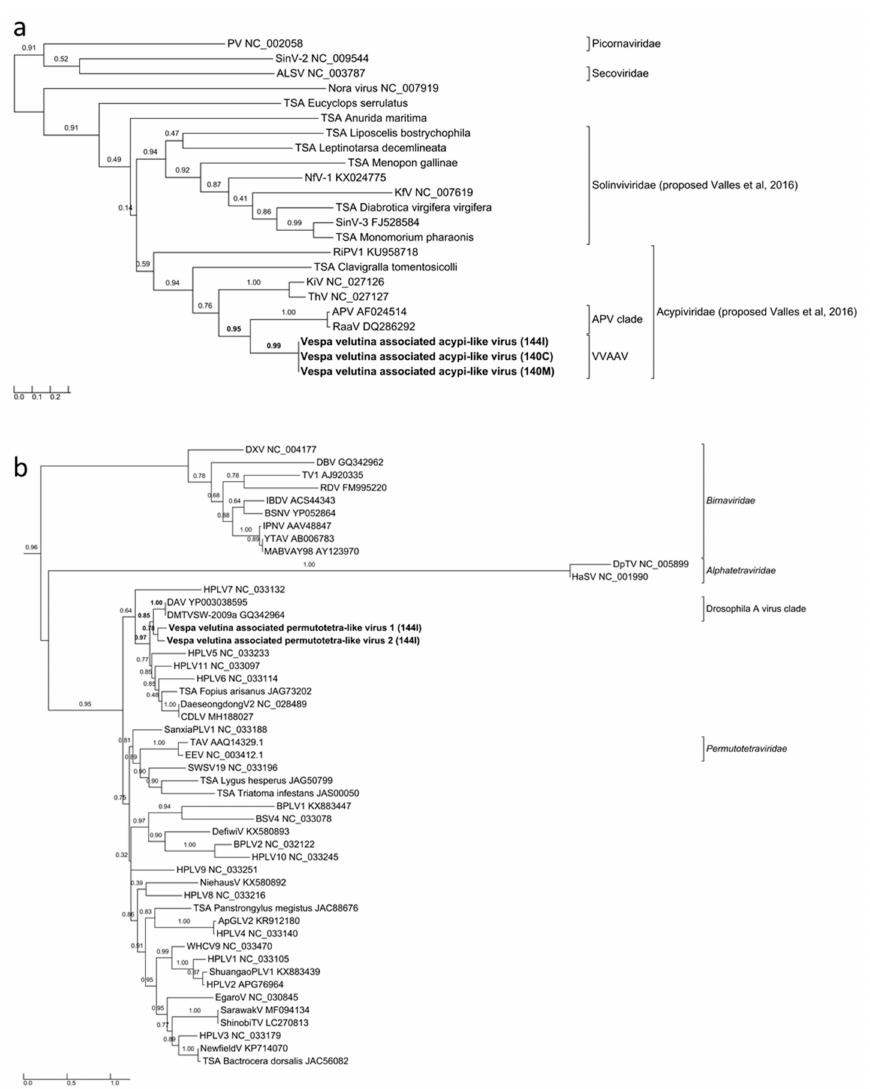
Figure 5. Maximum likelihood amino acid replicase phylogeny of ( a ) Vespa velutina associated acypi-like virus (277 aa, RtREV + G + I + Fmodel), and ( b ) Vespa velutina associated permutotetra-like virus 1 and 2 (219 aa, LG + G model). GenBank accessions are shown in Table